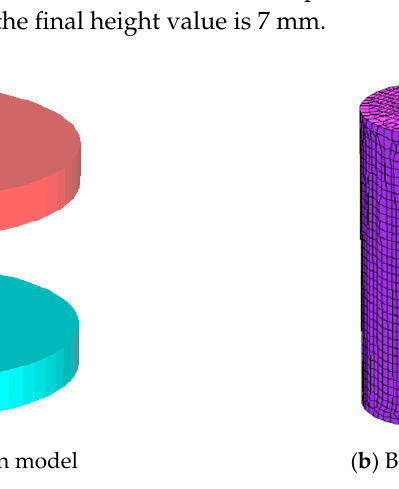
Figure 6. Simulation of the manufacturing of disks by isothermal compression, where the initial cylindrical billet (in purple colour) has a diameter of 18 mm and a length of 36 mm.